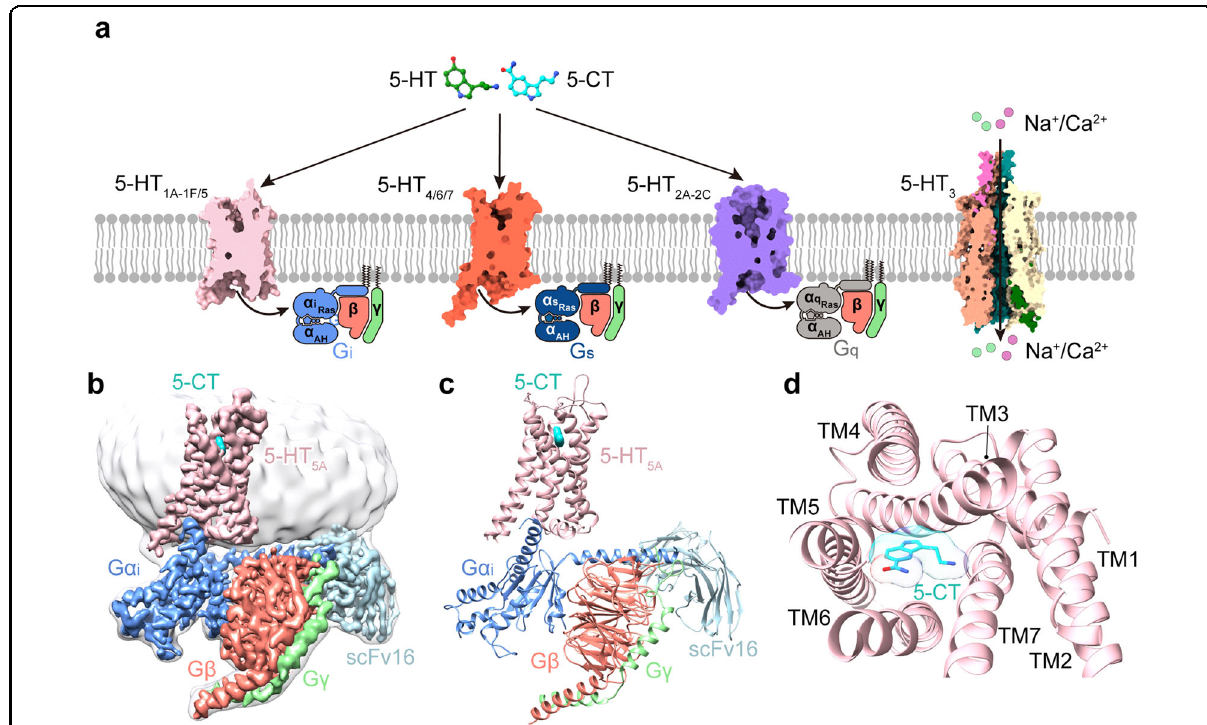
Fig. 1 Cryo-EM structure of the 5-CT – 5-HT 5A – G i – scFv16 complex. a Schematic illustration of 5-HT receptors coupling to distinct G proteins upon stimulation by 5-HT and 5-CT. 5-HT 1 and 5-HT 5 belong to G i/o -coupled 5-HT receptors. 5-HT 1 subfamily includes 5-HT 1A , 5-HT 1B , 5-HT 1D , 5-HT 1E , and